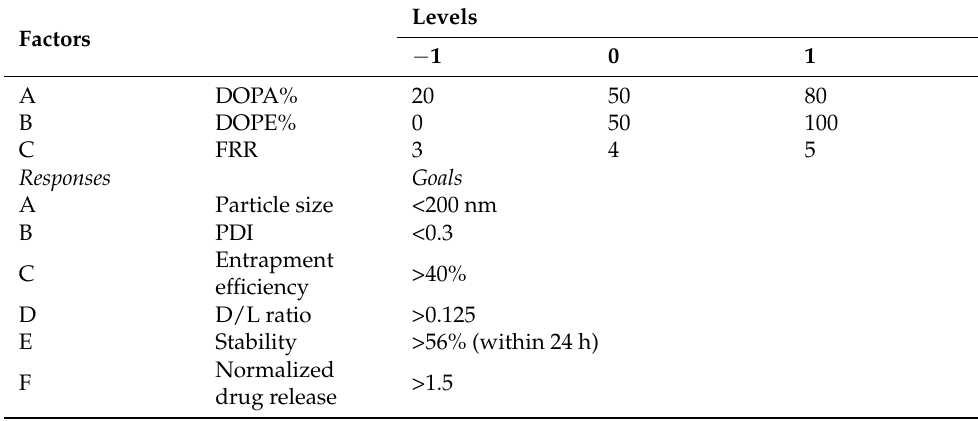
Table 2. Factors and responses used in Box–Behnken design for optimization.